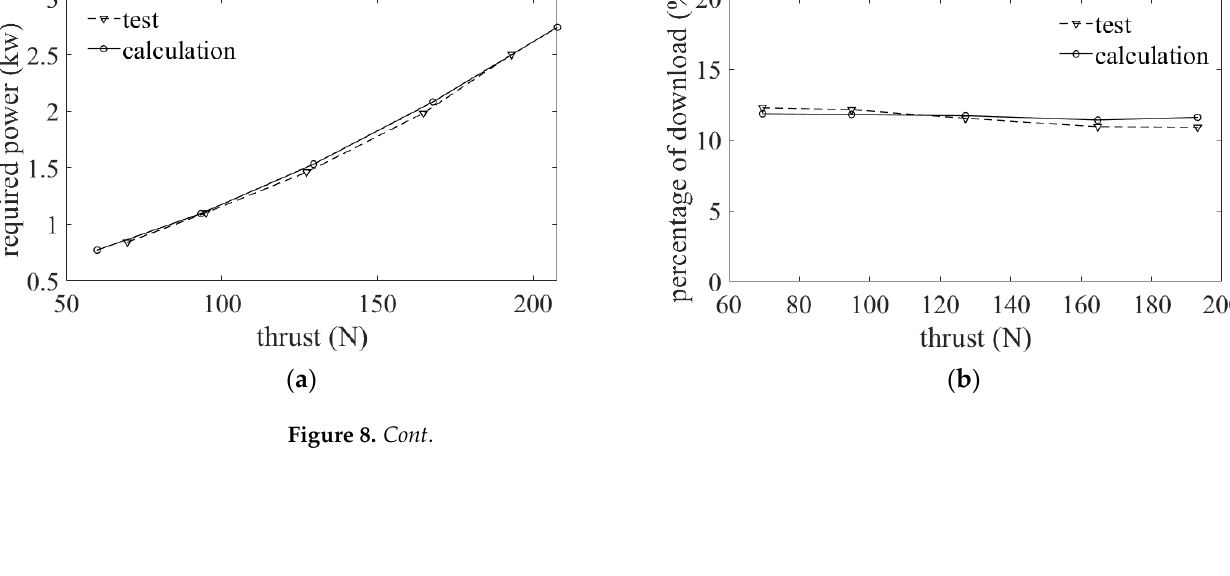
Figure 7. Experiment of the rotor thrust and the rotor – wing interaction. ( a ) The wind tunnel. ( b ) Experiment of the rotor thrust. ( c ) Experiment of the rotor – wing interaction.